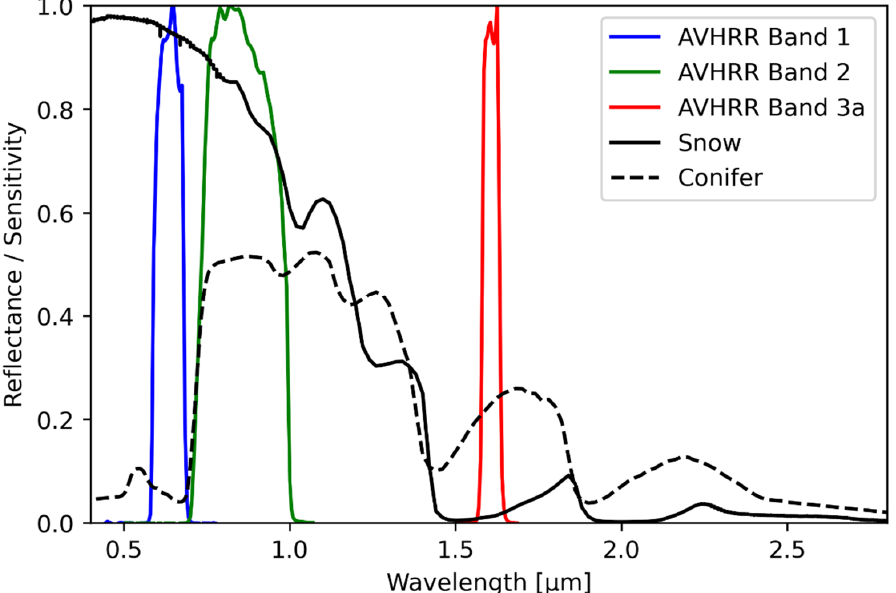
Figure 1. Reflective properties of snow compared to vegetation. The spectral response functions (sensitivity) for the AVHRR bands 1 to 3a are shown, with channels 1 and 2 being available for all AVHRR sensors, but channel 3a only for the third generation (AVHRR/3) and on MetOP-A and -B. In the reflection spectrum of snow, there is almost complete reflection in the visible spectral range (VIS: 0.38–0.78 µ m). The reflection decreases rapidly in the near infrared (NIR: 0.78–1.4 µ m), and in the short-wavelength infrared (SWIR: 1.4–3.0 µ m), the radiation is almost completely absorbed. This extremely different reflection between VIS and SWIR is used in many methods for determining snow surfaces. Most methods for distinguishing between clouds and snow use a decision tree with fixed thresholds [8,9], which have to be adjusted individually depending on the region under consideration, such as the Alps [12,13]. The snow products from MODIS [3] are no longer based on fixed threshold values; instead, a normalized index is used that still maps the reflection gradient between VIS and SWIR well, even with lower reflections. Equation (1) shows the calculation of the Normalized Difference Snow Index ( NDSI ) [18] based on the AVHRR/3 spectral bands: